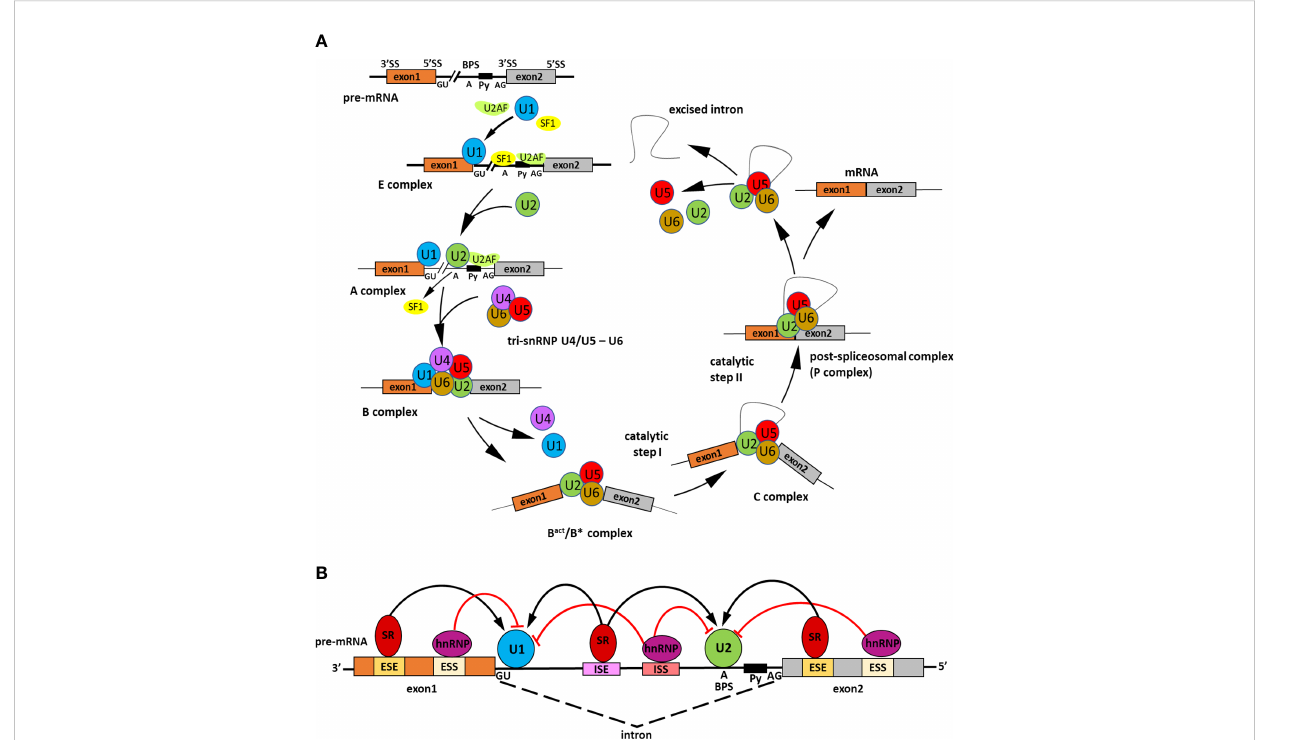
FIGURE 1 Scheme representing the splicing process and its regulation. (A) Steps of spliceosome assembly on precursor messenger RNA (pre-mRNA). Precise pre-mRNA splicing requires four constitutive motifs present in the intronic sequence: the 5 ′ splice site (GU), the 3 ′ splice site (AG), the branch point sequence (BPS), and the polypyrimidine tract (Py). The intron excision by the spliceosome is divided into several main stages. In the early step of splicing the E complex is generated. Firstly, splicing factor U1 snRNP U1 small nuclear ribonucleoprotein (U1 snRNP) attaches to the 5 ′ splice